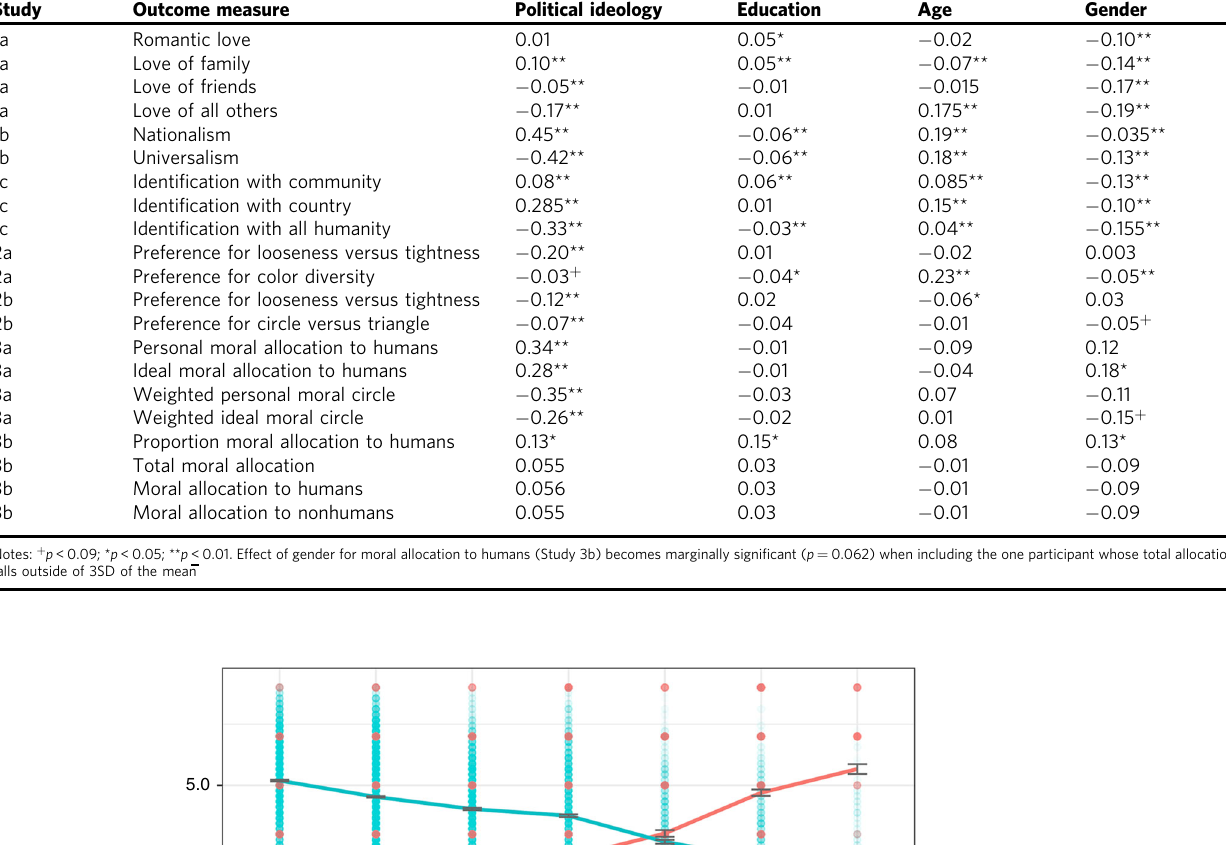
Table 1 Standardized betas for regressions using political ideology, education, age, and gender Study